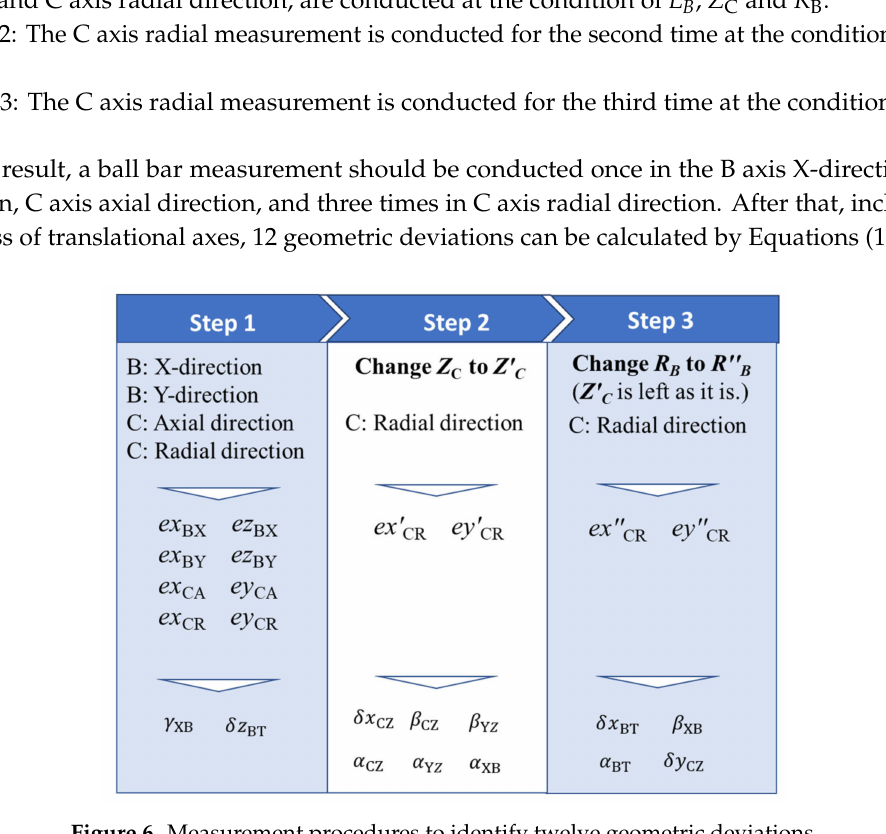
Figure 6. Measurement procedures to identify twelve geometric